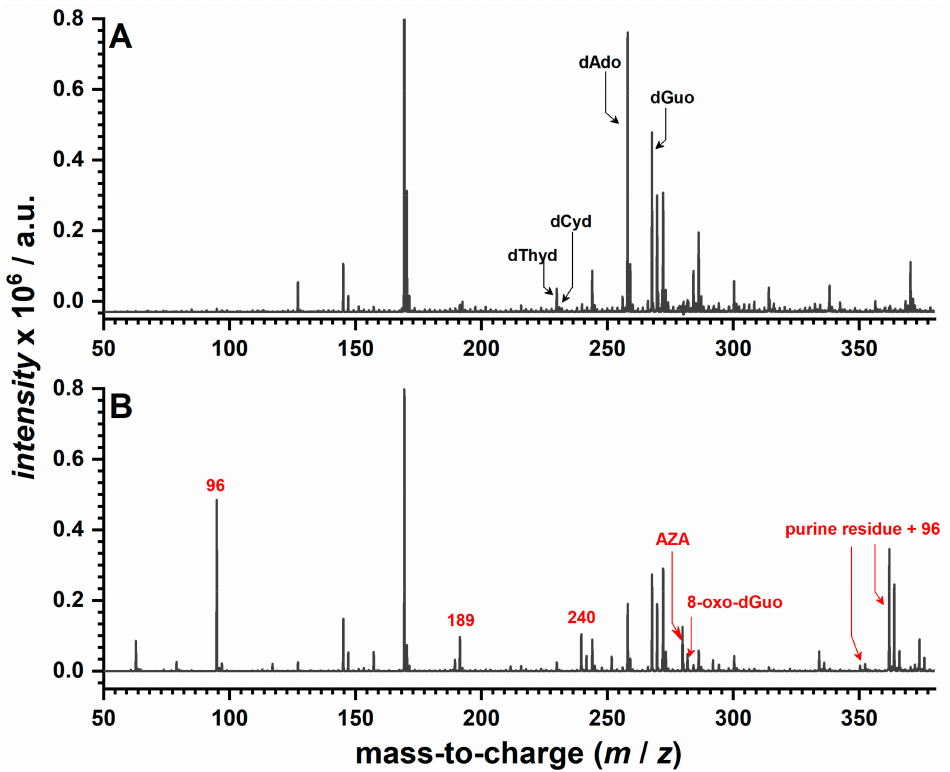
Figure 8. MS spectra for the acid-digested dsDNA: ( A ) before and ( B ) after incubation at − 0.60 V in 500 µ M AZA for 30